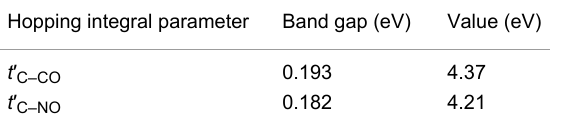
extracted and presented in Table 2. Table 2: The extracted hopping integral parameters for CO and NO adsorption, where t ′ C–CO and t ′ C–NO represent the hopping integrals between CO and NO gas molecules and the armchair graphene nanoribbon (AGNR)